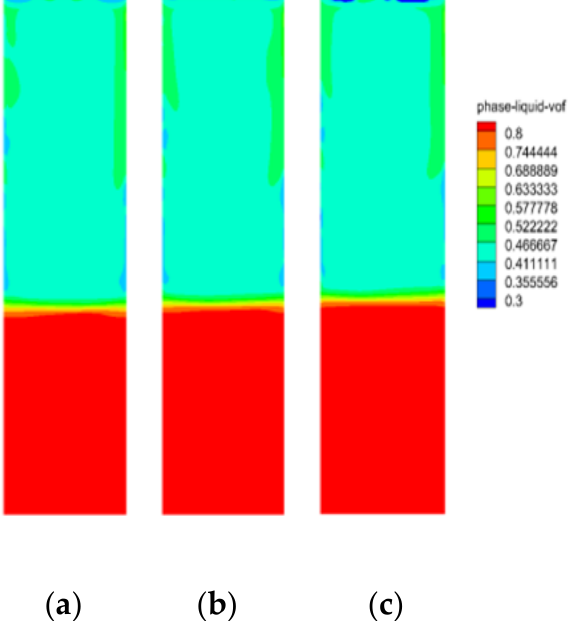
Figure 8. Distribution of the liquid volume fraction of xy -plane slice during the separation process at 60 s, where the surface tensions are σ = 0.04 ( a ), σ = 0.055 ( b ), σ = 0.07 ( c ), respec- tively.